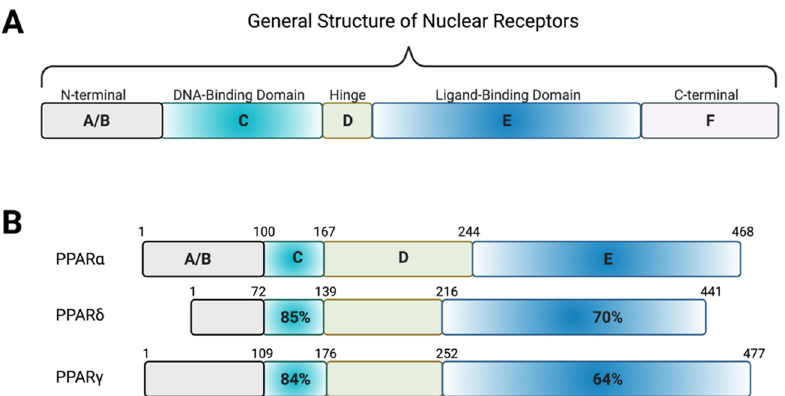
Figure 5. Homology of the PPAR receptors. ( A ) Schematic showing the general structure of nuclear receptors. The N-terminal A/B region contains the ligand-independent activation of function-1 region, which is highly variable among the nuclear receptors. The DNA-binding domain consists of two zinc fingers that can recognize and bind specific sequences of DNA or response elements. This region is highly conserved among the nuclear receptors. The highly variable hinge region connects the DNA-binding domain to the ligand-binding domain, a hydrophobic region consisting of alpha helices that bind natural or synthetic ligands to induce transcriptional regulation of target genes. In most nuclear receptors, the ligand-binding domain contains the ligand-dependent activation of function-2 region, which is important in the recruitment of co-activators. At the C-terminal, there is often a highly variable region present which aids in the stabilization and recruitment of co-activators. ( B ) The three PPAR isoforms share amino acid sequence homology of the DNA-binding and ligand-binding domains. Figure created with BioRender (accessed on 7 February